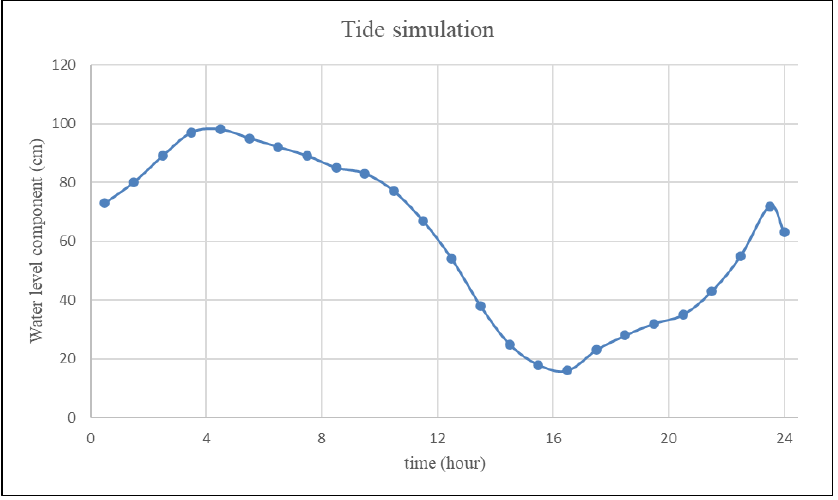
Figure 17. Simulated tide change.